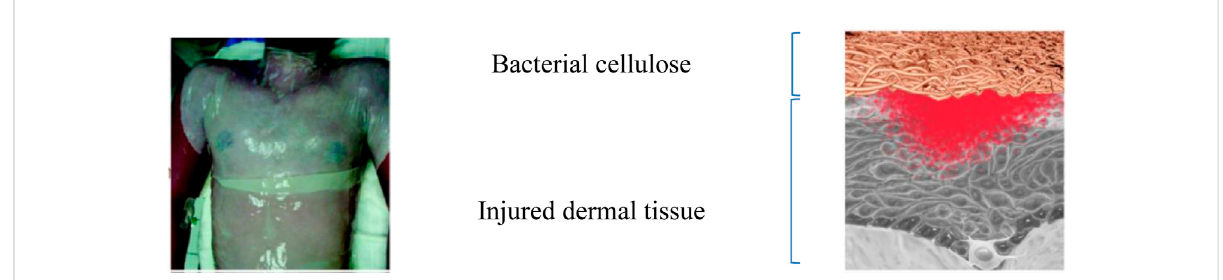
FIGURE 1 The BC membrane as a wound dressing and the BC network covering the injured area in detail. Source: adapted from (Oliveira Barud et al.,